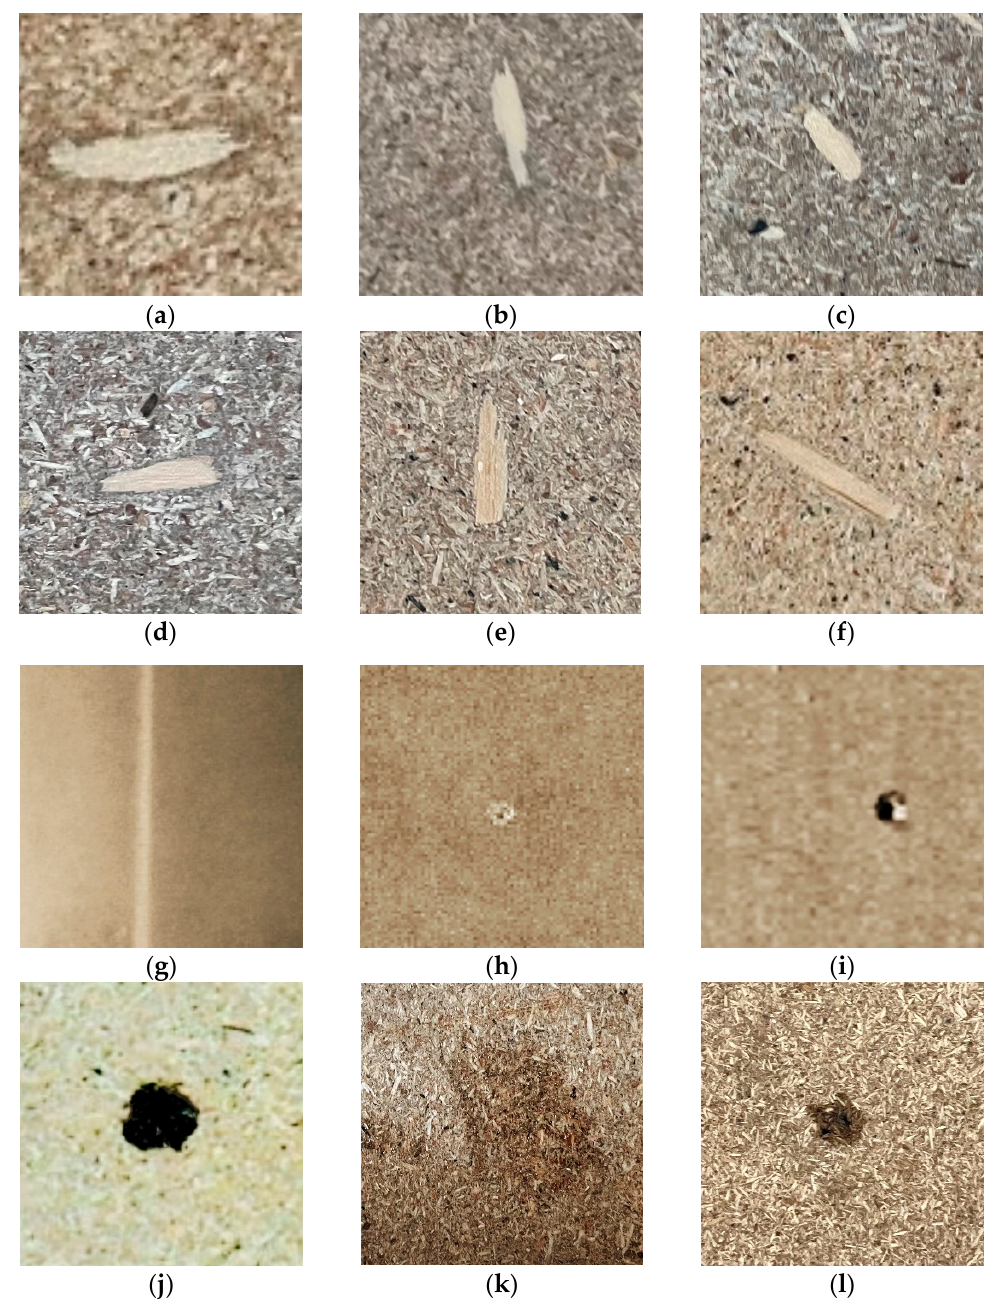
Figure 8. Part of the sample images contains surface defect features ( fi gure ( a – f ) are shavings; ( g ) is sand grain; ( h , i ) are holes; ( j ) is glue spot; ( k , l ) are oil stains). sand grain; ( h , i ) are holes; ( j ) is glue spot; ( k , l ) are oil